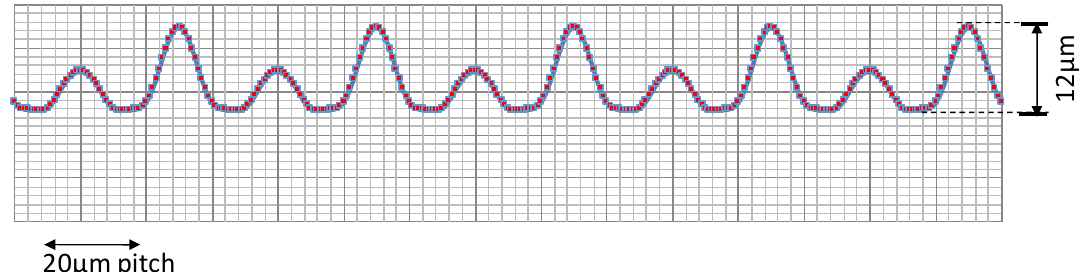
Figure 2. A synthesized microtexture for femtosecond laser microtexturing.